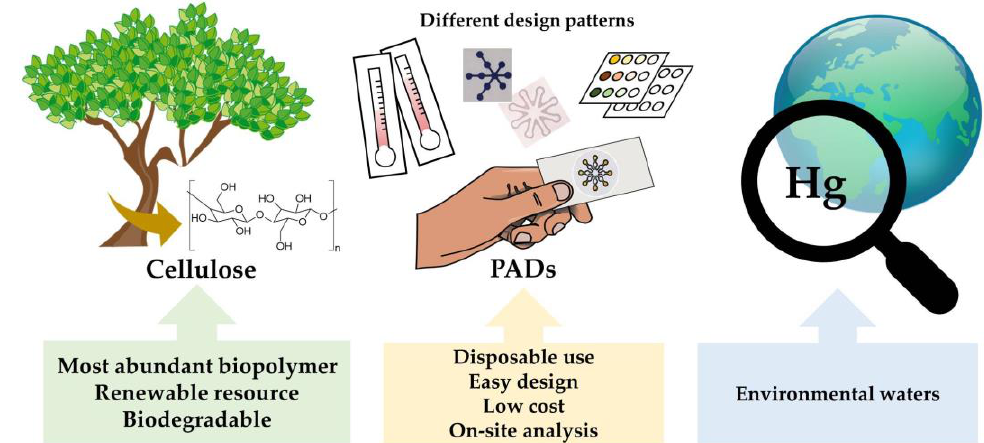
Figure 1. Conceptual scheme showing the application of cellulose for the detection of Hg.